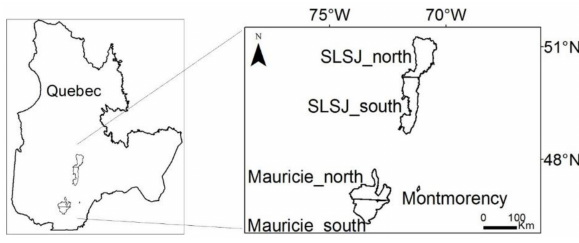
Figure 1. Location of the study sites.